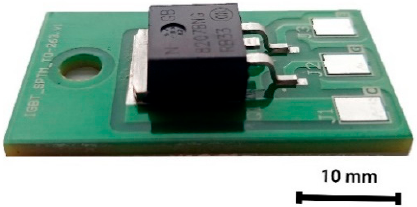
Figure 2. Test sample of NGB8207BN transistors soldered onto FR4 substrate.